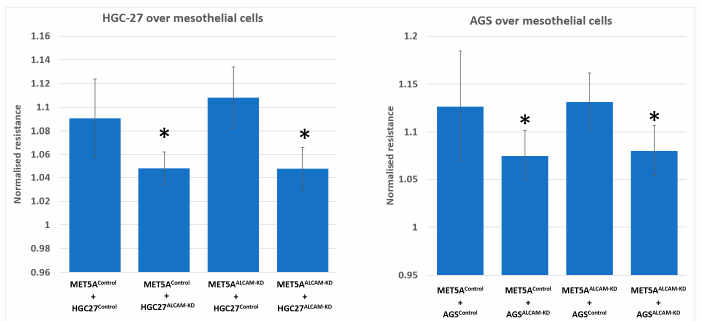
Figure 4. Interaction between HGC-27 ( left ) or AGS ( right ) gastric cancer cells and MET5A mesothelial cells. Both gastric cancer cell lines after knocking down ALCAM showed reduced adhesion to MET5A mesothelial cells. * Groups of cells with ALCAM knockdown compared with the groups of control MET5A cells plus control cancer cells ( p < 0.05, replicate n = 4).